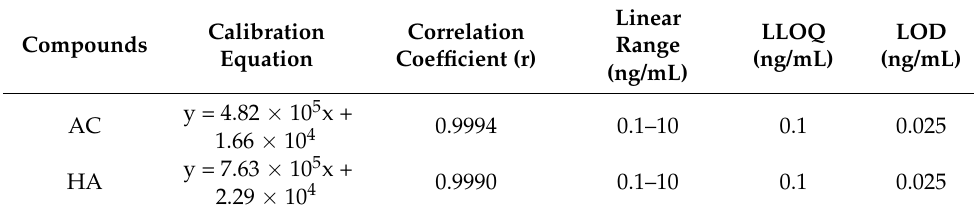
Table 1. The calibration equations, linear ranges, correlation coefficients, LLOQ, and LOD of the six compounds in rat